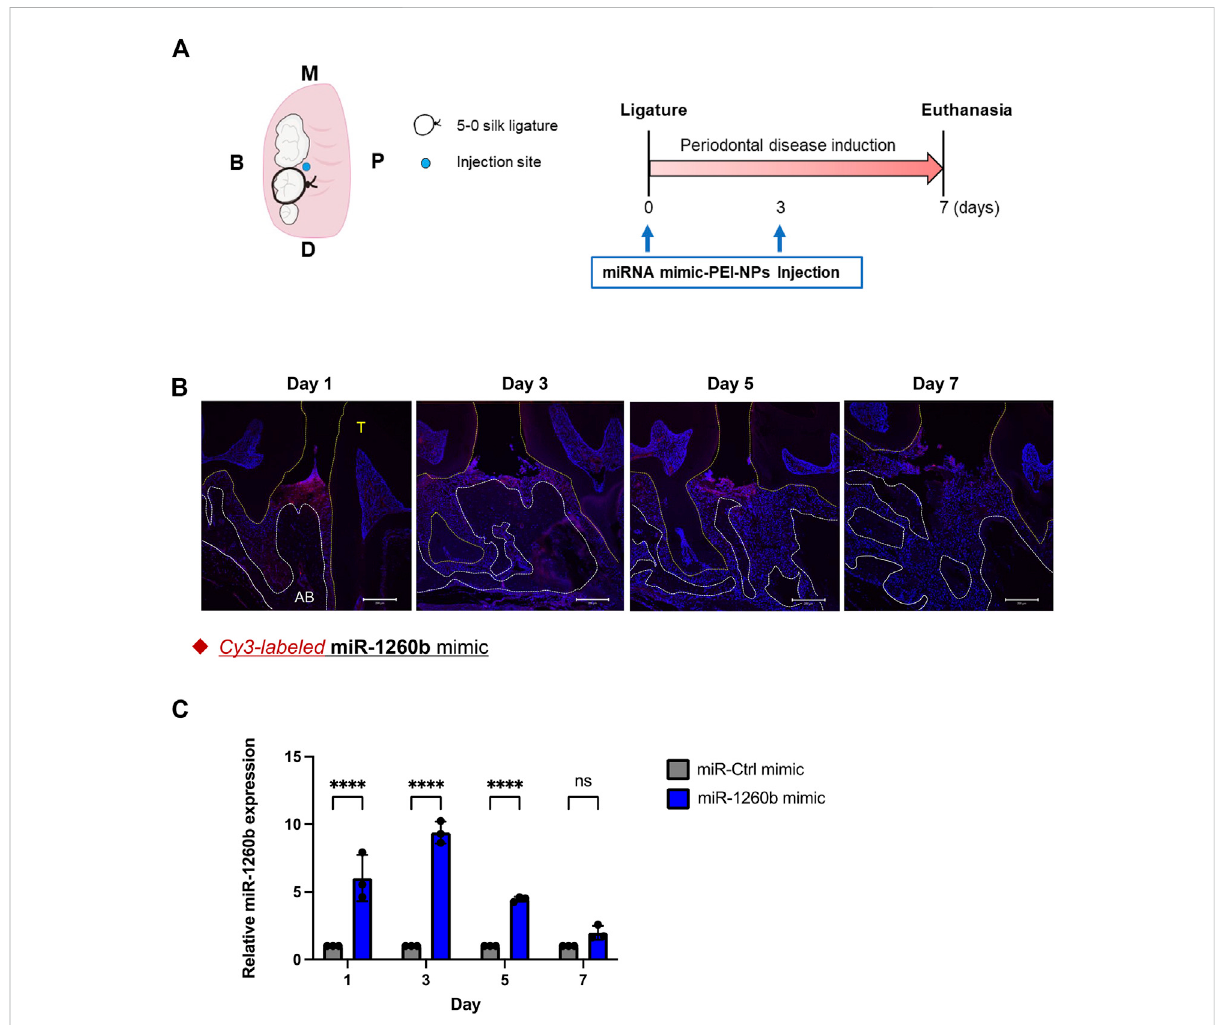
Distribution of locally injected miR-1260b mimic-polyethylenimine nanoparticles (PEI-NPs) in the mice periodontal model. (A) Schematic illustration of the ligature-induced periodontitis model and local administration of miRNA-PEI-NPs. A 5-0 silk ligature was tied around the maxillary second molar in C57BL/6 mice on day 0. On day 0 and 3, a total of 10 μ l of miR-PEI-NPs (miR: 125 pmol) was injected as illustrated. (B) Detection of injected miRNA in mice periodontal tissue. miRNAs were Cy-3 labeled (Red) before administration. Nuclei were stained with 4, 6-diamino-2- phenylindole (DAPI; blue). AB: alveolar bone, T, teeth. Scale bar = 200 μ m. (C) Time course expression of miR-1260b in mice gingiva ( n = 3). ns, not signi fi cant, **** p < 0.0001. Error bars represent the mean ± SD. The signi fi cance of differences between groups was determined using two-way analysis of variance (ANOVA), followed by correction for multiple comparisons with Tukey ’ s post hoc